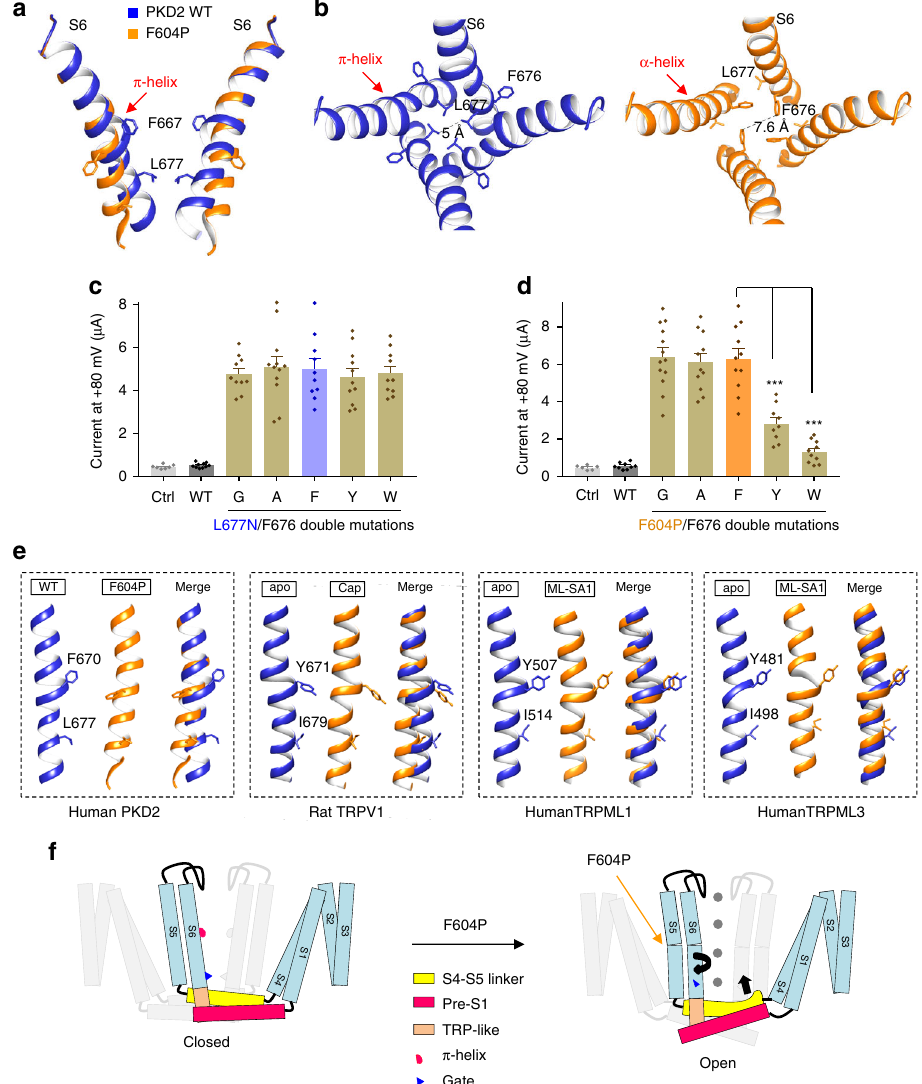
Fig. 6 PKD2 S6 conformational changes induced by F604P mutation. a Side view of superposition of S6 in the PKD2 WT (blue) and F604P (orange). The π -helix in the WT structure is indicated by an arrow. The F667 residue, located in the π -helix, and gate residue L677 are shown. b Top view of the pore lined by S6 in the PKD2 WT and F604P structures showing twisting and bending movements of distal S6 induced by the transition of π -helix to α -helix. c , d Averaged currents at + 80 mV obtained under the same experimental conditions as in Fig. 3a in oocytes injected with cRNA of PKD2 WT, L677N/F676 ( c ) or F604P/F676 ( d ) double mutant. Currents were averaged from 10 – 13 oocytes. Ctrl, water-injected oocytes. Data are presented as mean ± SEM. Statistic signi fi cance was determined by Student ’ s t -test. *** P < 0.001. e Comparison between S6 in the closed (blue) and open (orange) states of PKD2, TRPV1, TRPML1 or TRPML3. The aromatic residue in the π -helix and hydrophobic gate residue were shown for each channel. PKD2 WT (PDB: 5T4D); TRPV1 apo (unliganded and closed state, PDB: 3J5P), Cap (capsaicin-bound state, PDB: 3J5R); TRPML1 apo (PDB: 5WJ5), ML-SA1 (agonist ML-SA1-bound state, PDB: 5WJ9); TRPML3 apo (PDB: 6AYE), ML-SA1 (6AYF). f Proposed mechanistic model for PKD2 activation induced by F604P mutation. The black arrows indicate proposed movements during the – 40 in TRPV1, -A1, -ML1, -ML3, -M4 and NOMPC 36 (Supple- 5.3 to 7.6 Å by capsaicin) 42 , TRPML1 (from 5.6 to 8.4 Å by ML- mentary Figure 10). By comparing the TRPV2 and TRPV1 struc- SA1) 43 and TRPML3 (from 5.3 to 10.4 Å by ML-SA1) 44 , despite the fact that they result from different gating motions (see tures, transition of this π -helix to a canonical α -helix was Discussion and Fig. 6e). In contrast to the dramatic changes of previously hypothesized to mediate TRPV2 gating 41 . Here, by directly comparing S6 of PKD2 WT and F604P mutant, we found distal S6, the proximal S6 above the π -helix remained rather a transition of the π -helix in WT PKD2 to the canonical α -helix stationary in PKD2 (Fig. 6a), suggesting that the transition from π - to α -helix alone is suf fi cient to induce pore opening and in F604P mutant. This transition in PKD2 induced a combined twisting and bending motion of the distal S6 below the π -helix, channel activation. The twisting motion in PKD2 not only resulting in twisting and splaying of gate residue L677 (Fig. 6a) induced the gate residue L677 to rotate and point away from the that expands the pore from 5 to 7.6 Å (Fig. 6b). The pore dilation pore center, but also resulted in turning of the precedent residue observed in the F604P mutant is similar to that of TRPV1 (from F676 towards the pore (Fig. 6b). In other words, the F676 points